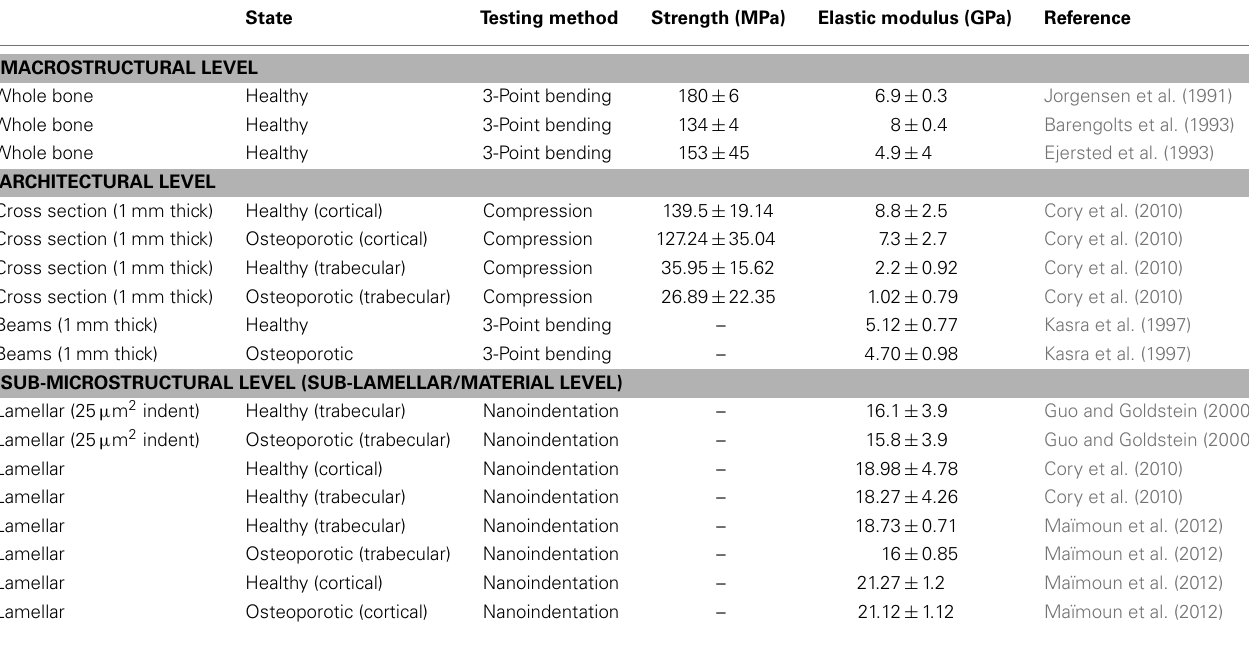
Table 1 | Mechanical properties of osteoporotic and comparative healthy rat bone taken from the literature